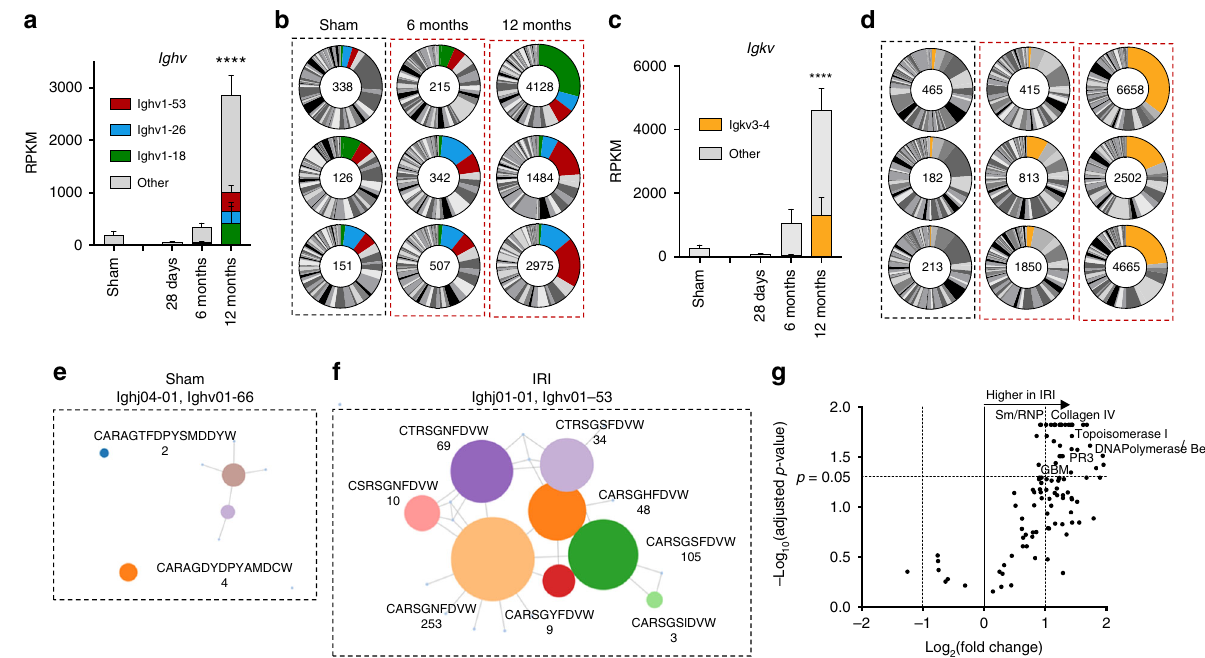
Fig. 5 B cell receptor analysis and detection of autoantibodies. a , c Absolute RPKM values for germline Ighv and Igkv transcripts in 3 replicates collected 6 and 12 months after IRI and from sham control (matched to the 12 month IRI samples). The most frequent genes are highlighted with colors as indicated (mean values and SE are shown; n = 3/group; Mann – Whitney test, **** P < 0.0001 in comparison to sham control). b , d Relative frequency of germline Ighv and Igkv transcripts over time indicating the enrichment of common genes in the late phase; the number indicates the total RPKM of Ighv and Igkv at each time point. e , f Immunoseq analysis showing representatives cluster of vj rearrangements in sham and IRI mice (both 12 months after surgery). Each circle represents a unique amino acid sequence. The sequence is reported in the fi gure if >2 rearrangements were detected. The number of rearrangements is indicated below the amino acid sequence. The lines connect the circles if the corresponding rearrangements differ only in 1 amino acid. g Volcano plot comparison of signal-to-noise ratio in IgG reactivity in plasma samples collected 16 – 18 months after IRI ( n = 6) and in age-matched controls ( n = 6) on a microarray of autoantigens, with indication of log 2 -fold change on the x -axis (>0 indicates higher in IRI) and signi fi cance level, expressed as log 10 of FDR- adjusted P -value. The name of representative antigens is